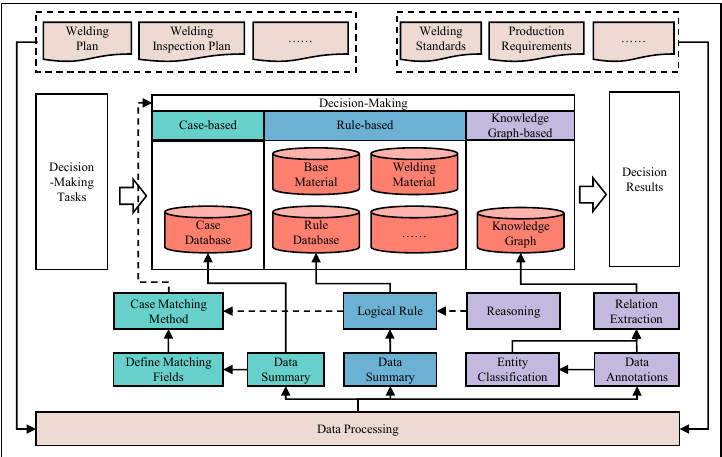
Figure 3. Hybrid decision-making process.